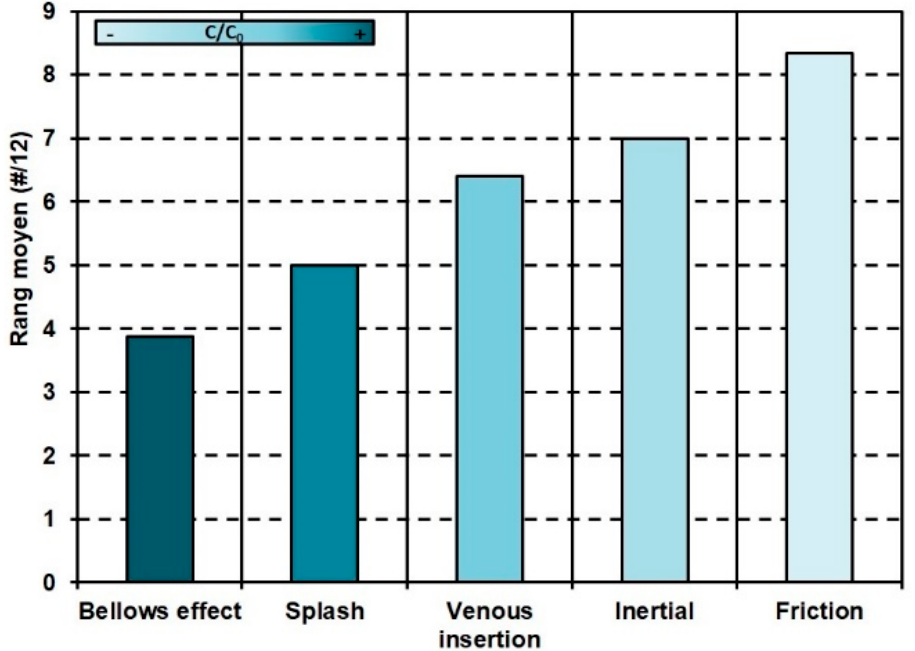
Figure 10. Average rank of maximum bioaerosol emission factors (descending order) by aerosolization.